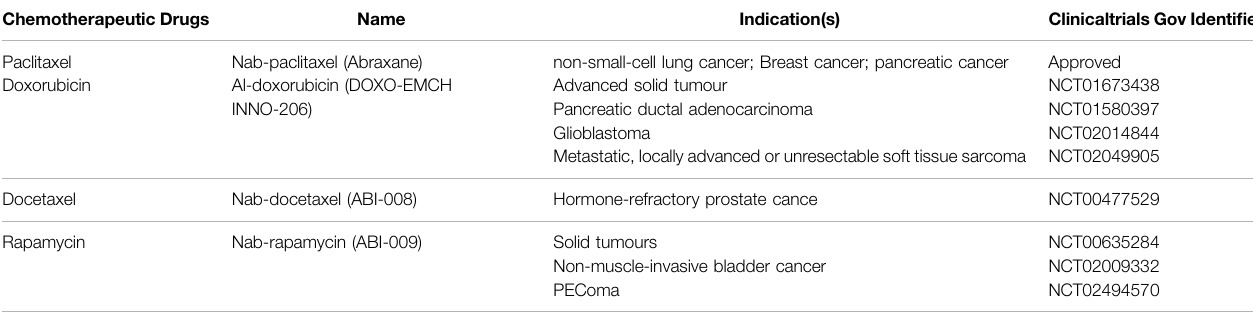
TABLE 2 | Albumin nanoparticles approved or in clinical trials for